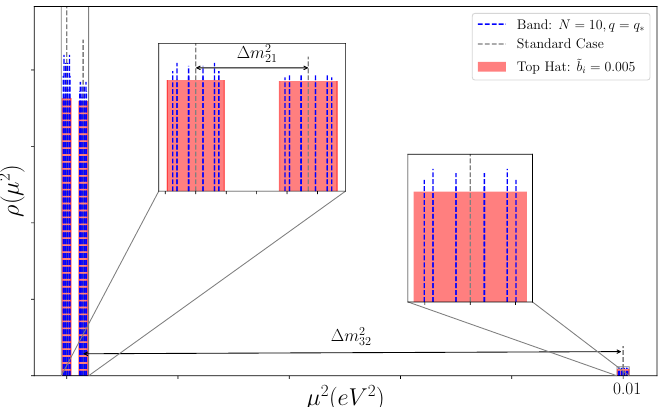
Figure 5. Evaluation of the top-hat phenomenological ansatz defined in section 2.5 to capture the oscillation behaviour of band models as defined in section